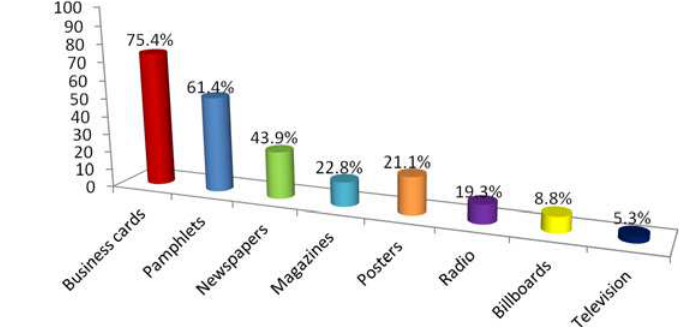
Fig. 2. Percentage of respondents having used traditional marketing tools